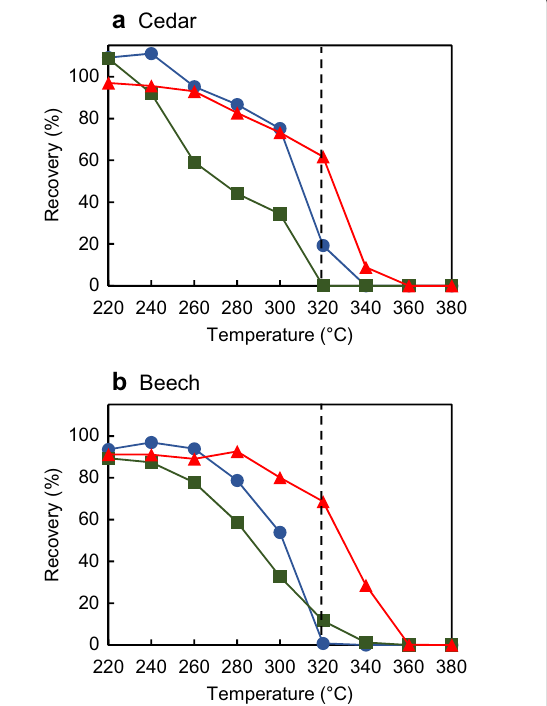
Fig. 6 Influences of pyrolysis temperature on the recovery rates of hydrolysable sugars, cellulose-derived glucose ( ), mannose ( ), and xylose ( ), in pyrolysis of cedar and beech holocellulose samples. Dashed lines at 320 °C are inserted to facilitate